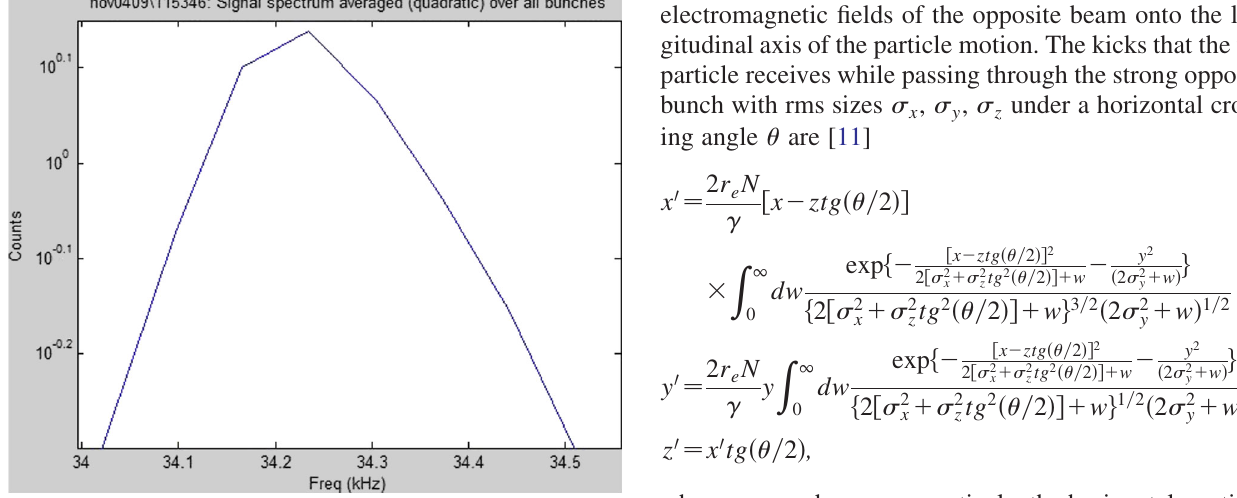
FIG. 7. The average synchrotron frequency (in collision) is 34.23